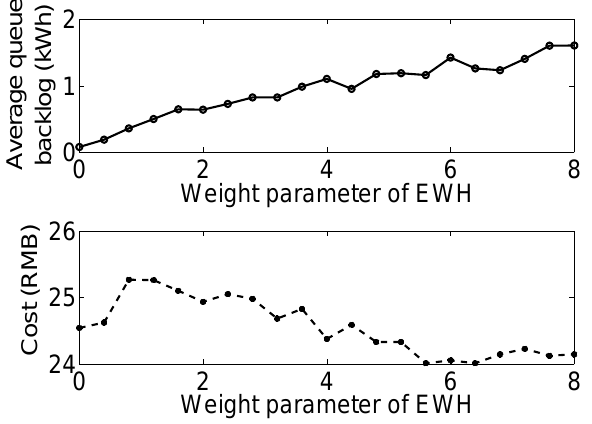
Figure 10. Average delay queue backlog of EWH and the electricity bills of controllable load.